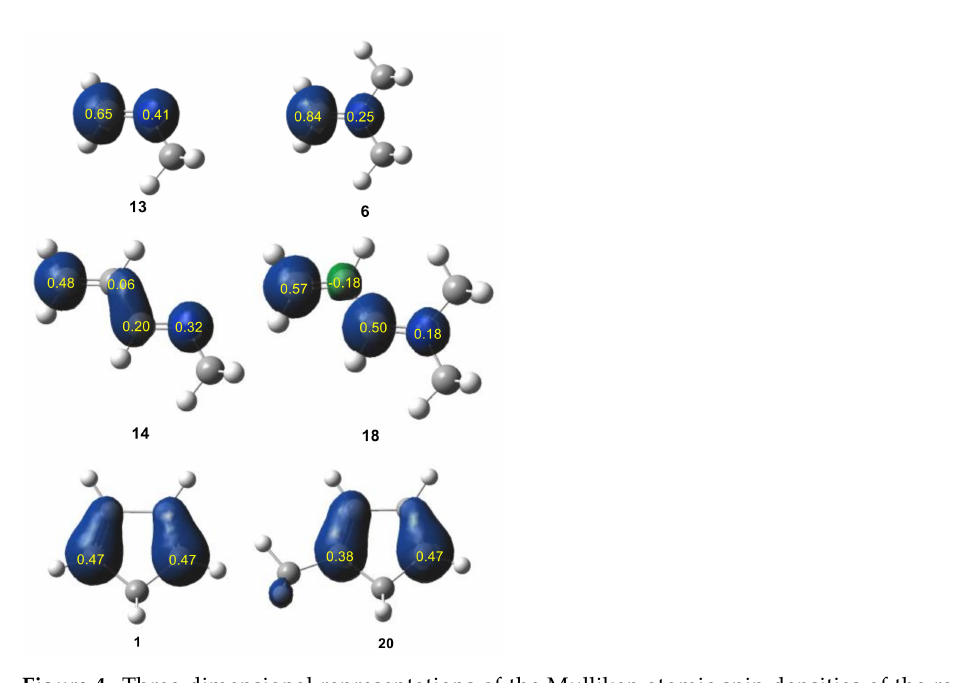
Figure 4. Three-dimensional representations of the Mulliken atomic spin densities of the radical anions of imines 13 and 14 , neutral radicals 6 and 18 , the radical cations of Cp 1 and CpMe 20 , and the Parr and nucleophilic P − electrophilic P + k k